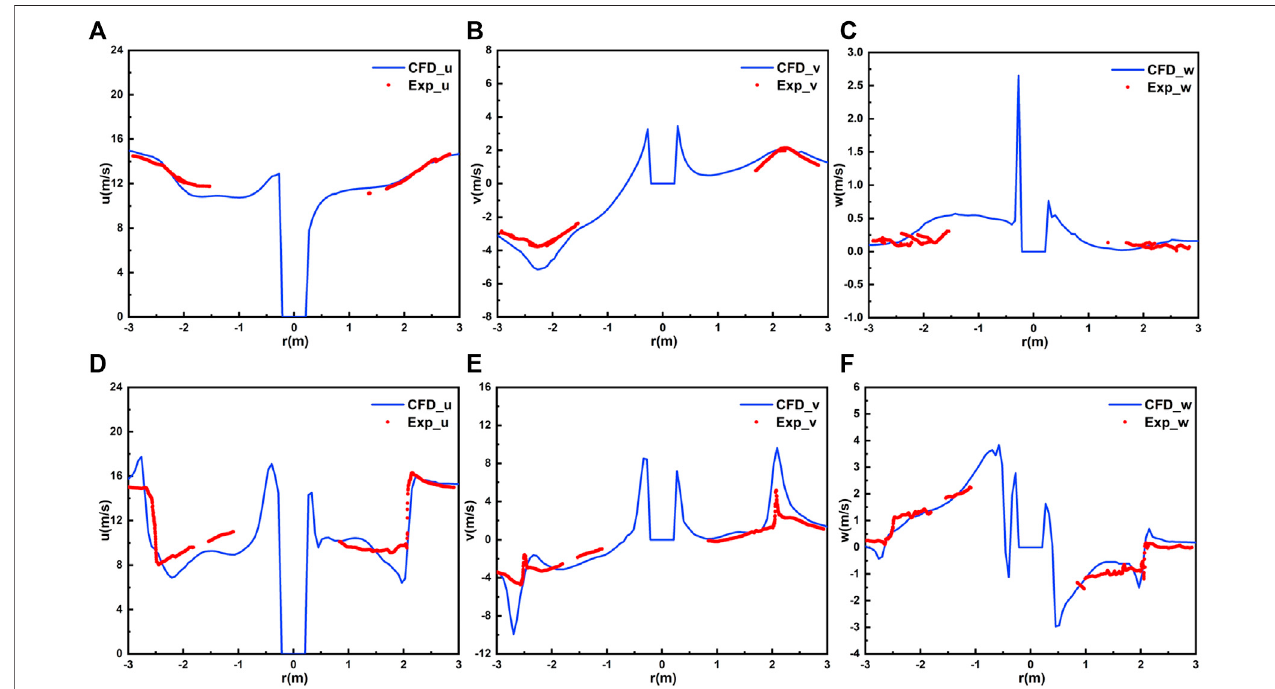
FIGURE 7 | Comparison of simulation values and experiment results of radial traverse of velocity in different directions in the horizontal plane of the hub height: (A) axial velocity at x ′ (cid:2) − 0 . 3m, u ; (B) radial velocity at x ′ (cid:2) − 0 . 3m, v ; (C) tangential velocity at x ′ (cid:2) − 0 . 3m, w ; (D) axial velocity at x ′ (cid:2) 0 . 3m, u ; (E) radial velocity at x ’ (cid:2) 0 . 3m, v ; (F) tangential velocity at x ’ (cid:2) 0 . 3m, w